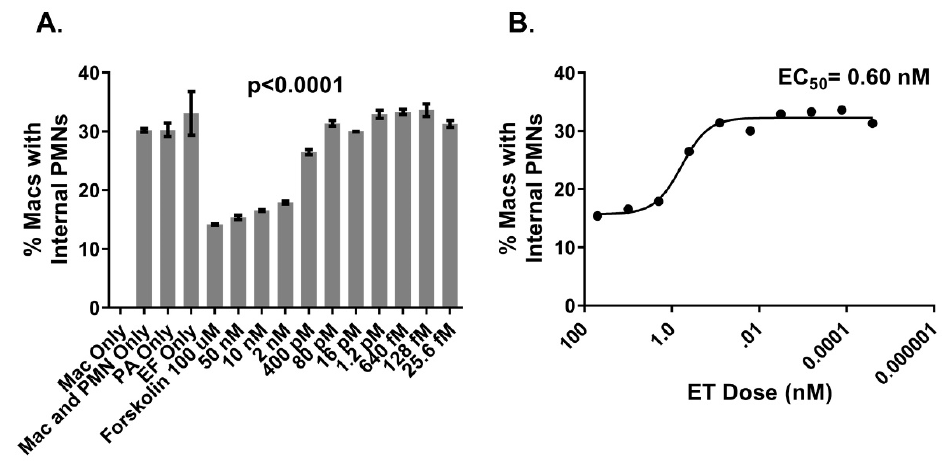
Figure 2. ET inhibits efferocytosis by M2(IL-4+IL-10+Dex) macrophages at a 50% effective concentration (EC 50 ) of 0.6 nM: ( A ) The inhibition of efferocytosis of apoptotic PMNs by various doses of ET. The controls included macrophages without added apoptotic PMN or ET (Mac Only), macrophages and apoptotic PMN without ET components (Mac and PMN Only), macrophages and apoptotic PMN with PA but without EF (PA Only), macrophages and apoptotic PMN with EF but without PA (EF Only), and an alternative stimulus for the induction of cAMP (Forskolin 100 µ M). The data were analyzed by one-way ANOVA compared to wells lacking ET; ( B ) The calculated EC 50 of the efferocytosis inhibition using log-transformed ET dose and four-parameter nonlinear regression.